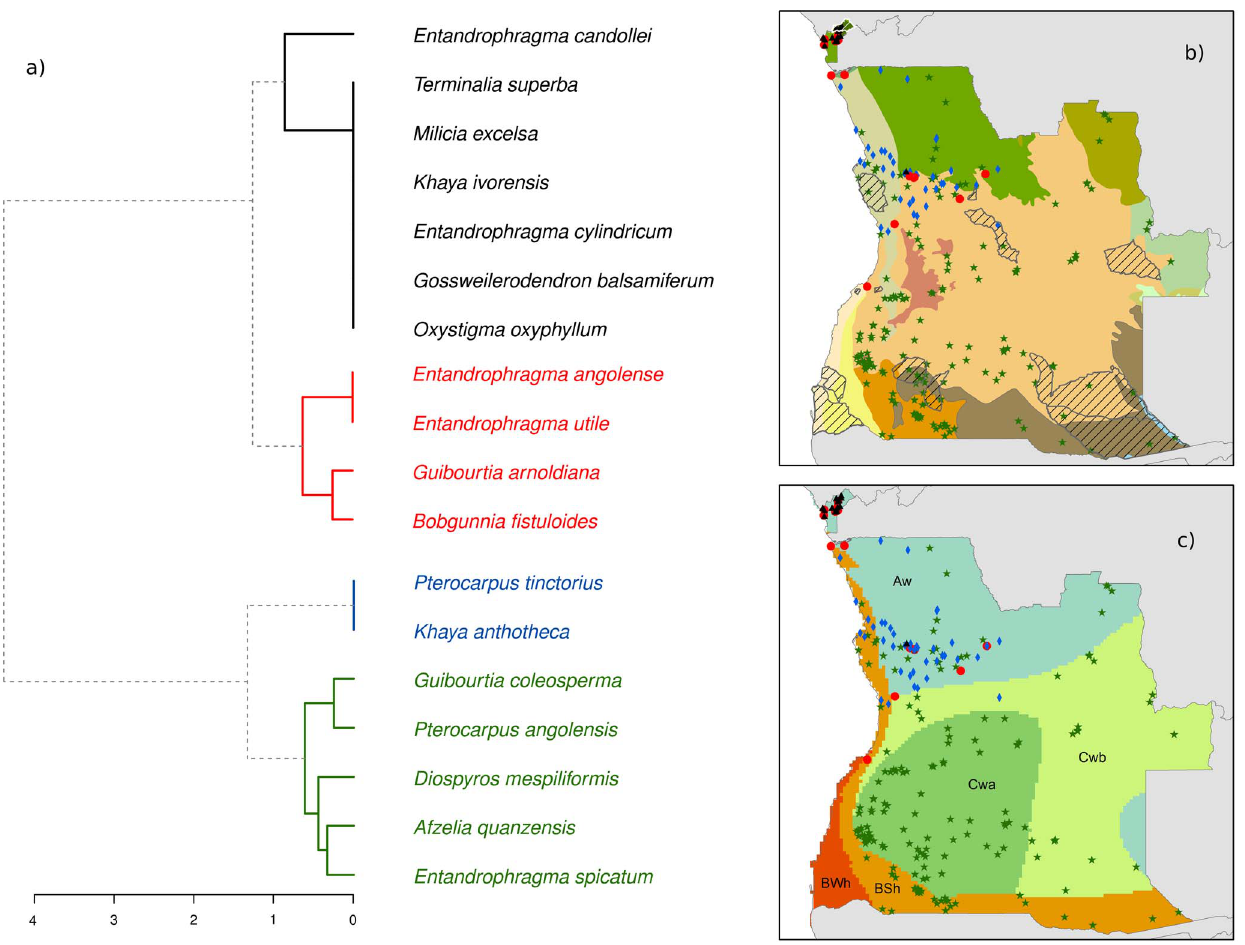
Figure 2. Biogeographical patterns of Angolan forest species selected for this study. a ) Dendrogram of a cluster analysis based on the distribution (presence/absence) of timber tree species in each of the ecoregions. Distribution of collection localities of the four species groups identified in this study, in relation to: b ) protected areas and the 15 WWF ecoregions represented in Angola; and c ) Ko¨ppen–Geiger climate classification. Clustering was based on the Jaccard index of similarity and on the Ward agglomeration algorithm.